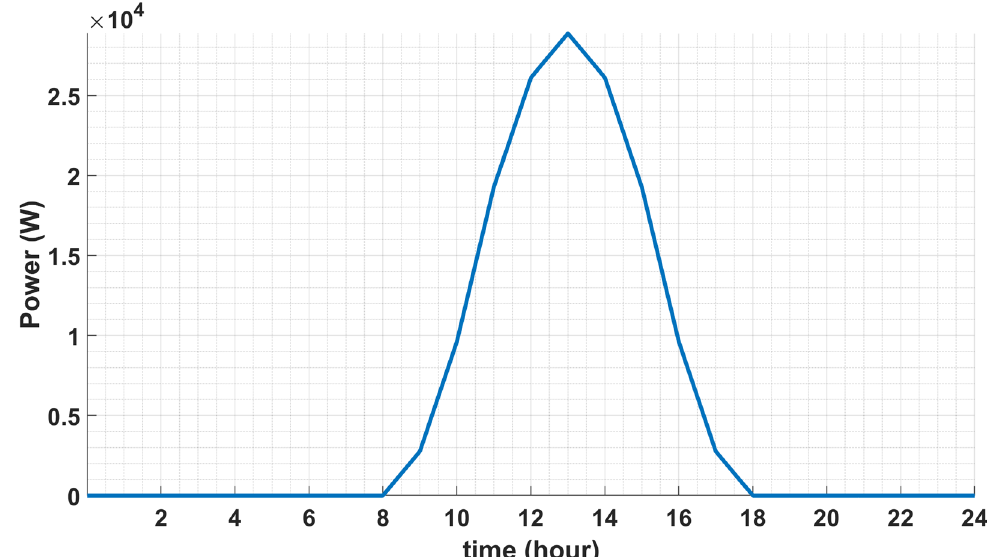
Figure 8. Total PVs output pattern.